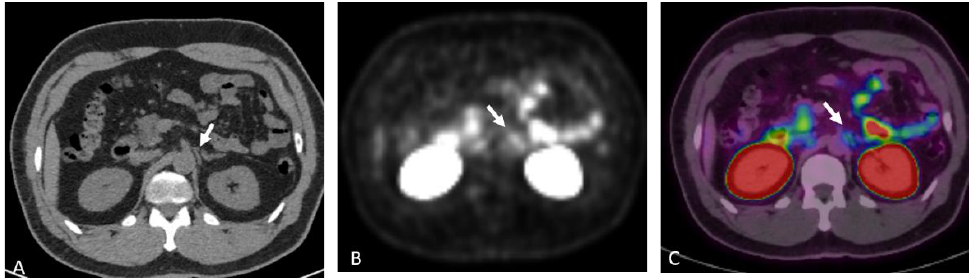
Figure 18. NECT ( A ), 18F DCFPyL PET ( B ), and fused PET/CT ( C ) images show curvilinear soft tissue, which demonstrate low-grade uptake (arrows). The location is characteristic for the celiac ganglion, a normal anatomic structure that can be mistaken for a pathologic lymph node.